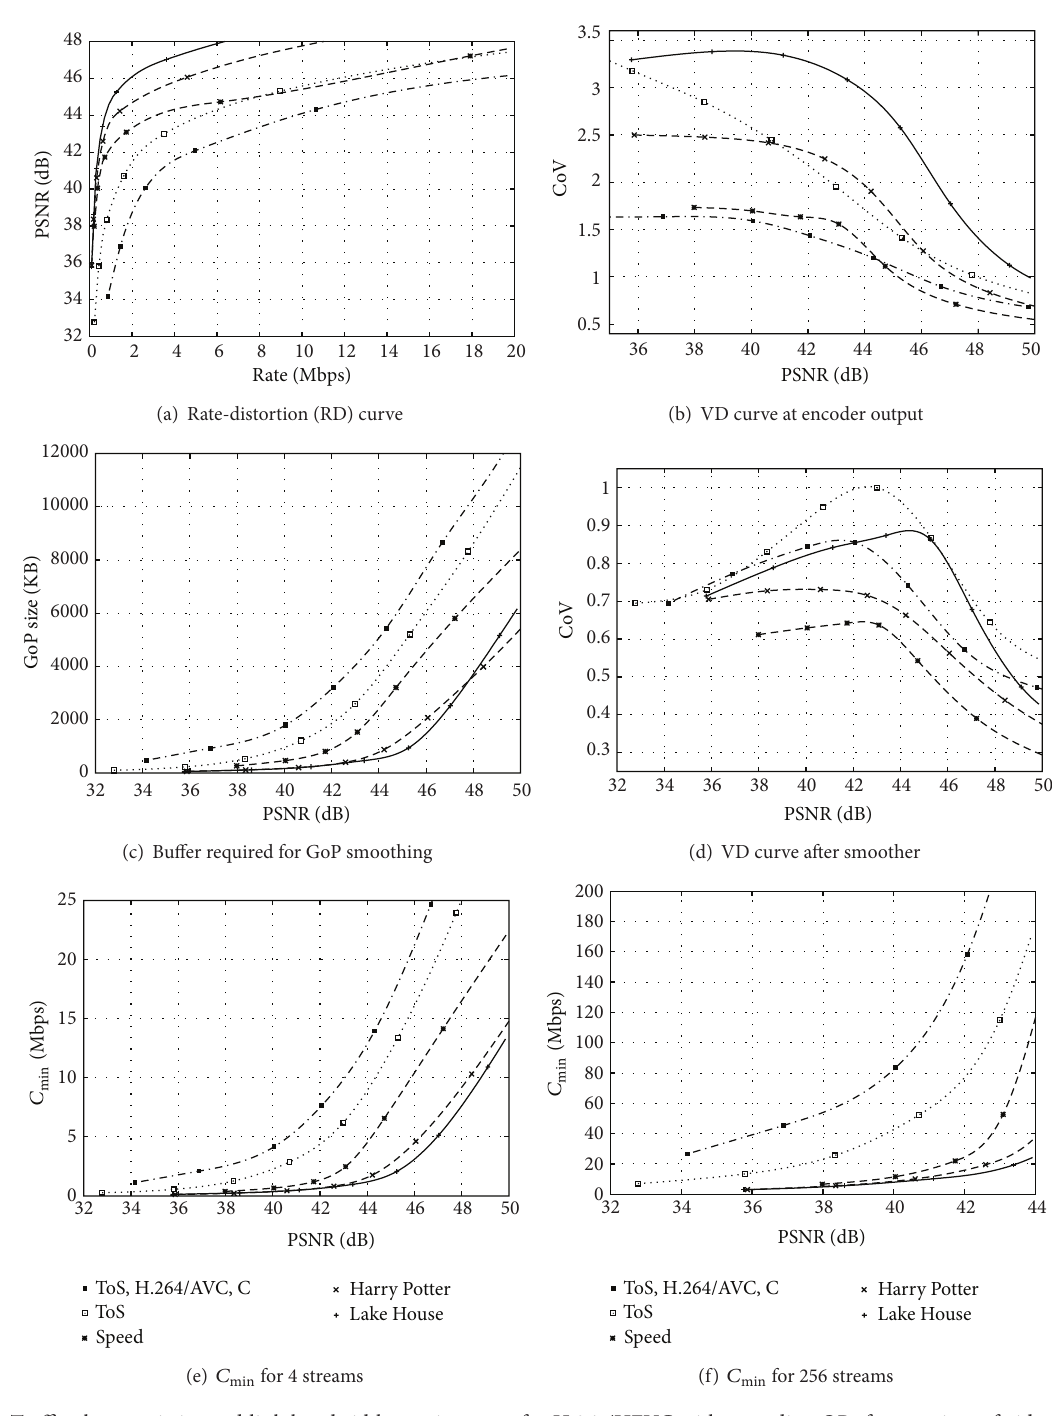
H.264/AVC as observed in Figures 3(b) and 4(b) do not